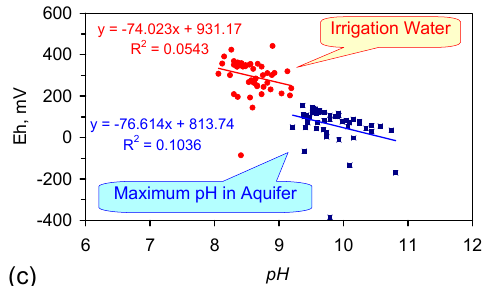
Figure C7. ST ZVI desalination pellets [16]; Type A Catalyst: Indicative Eh and pH of the irrigation water, maximum pH/minimum Eh in the aquifer as a function of P w . ( a ) pH vs. P w ; ( b ) Eh vs. P w ; ( c ) Eh vs. pH. Data Source: Desalination Pellet Trials ST1a to ST5j [16]. Feed water pH = 5.8–6.6.